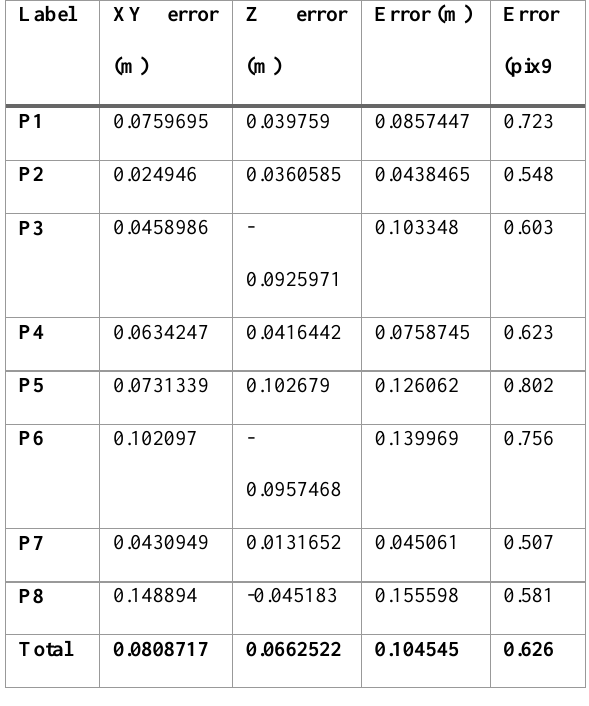
photogrammetric bundle adjustment